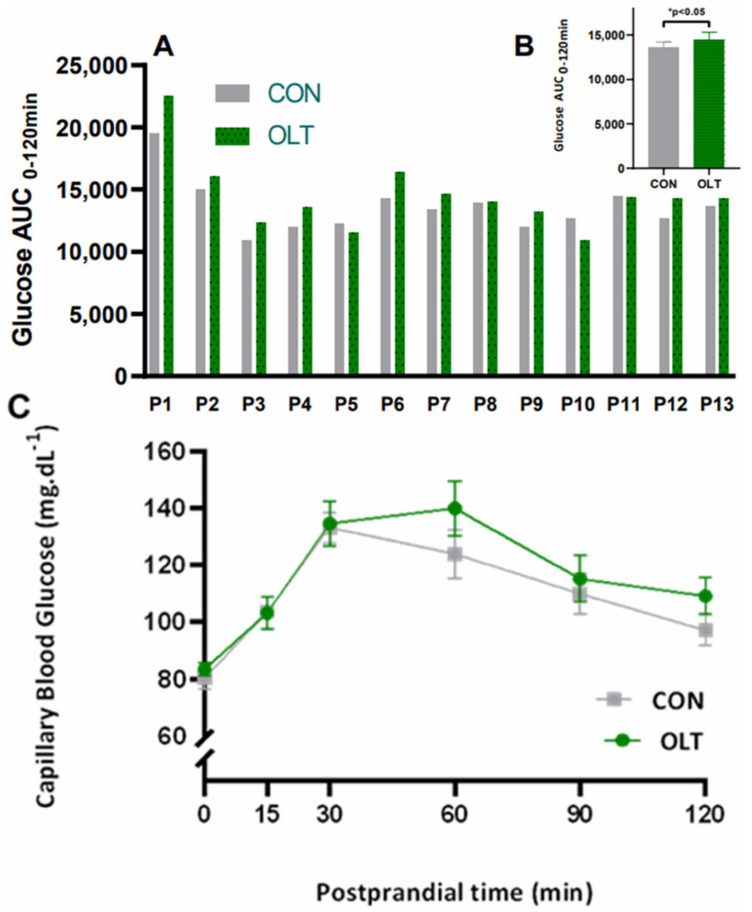
Figure 1. Individual responses ( A ) and summary mean ( B ) of postprandial glucose AUC from 0 to 120 min of 13 subjects and postprandial capillary plasma glucose from 0 to 120 min ( C ) after a mixed meal intervention composed of 2 slices of wheat bread (110 g) and 50 g of peach jam with olive leaf tea (OLT) or two slices of wheat bread (110 g) and 50 g of peach jam with 250 mL of placebo tea (CON). Glucose AUCs after OLT are significantly higher than CON. * p < 0.05 obtained after Wilcoxon matched-pairs signed rank test. Table 3. Glycemic responses of the two separate